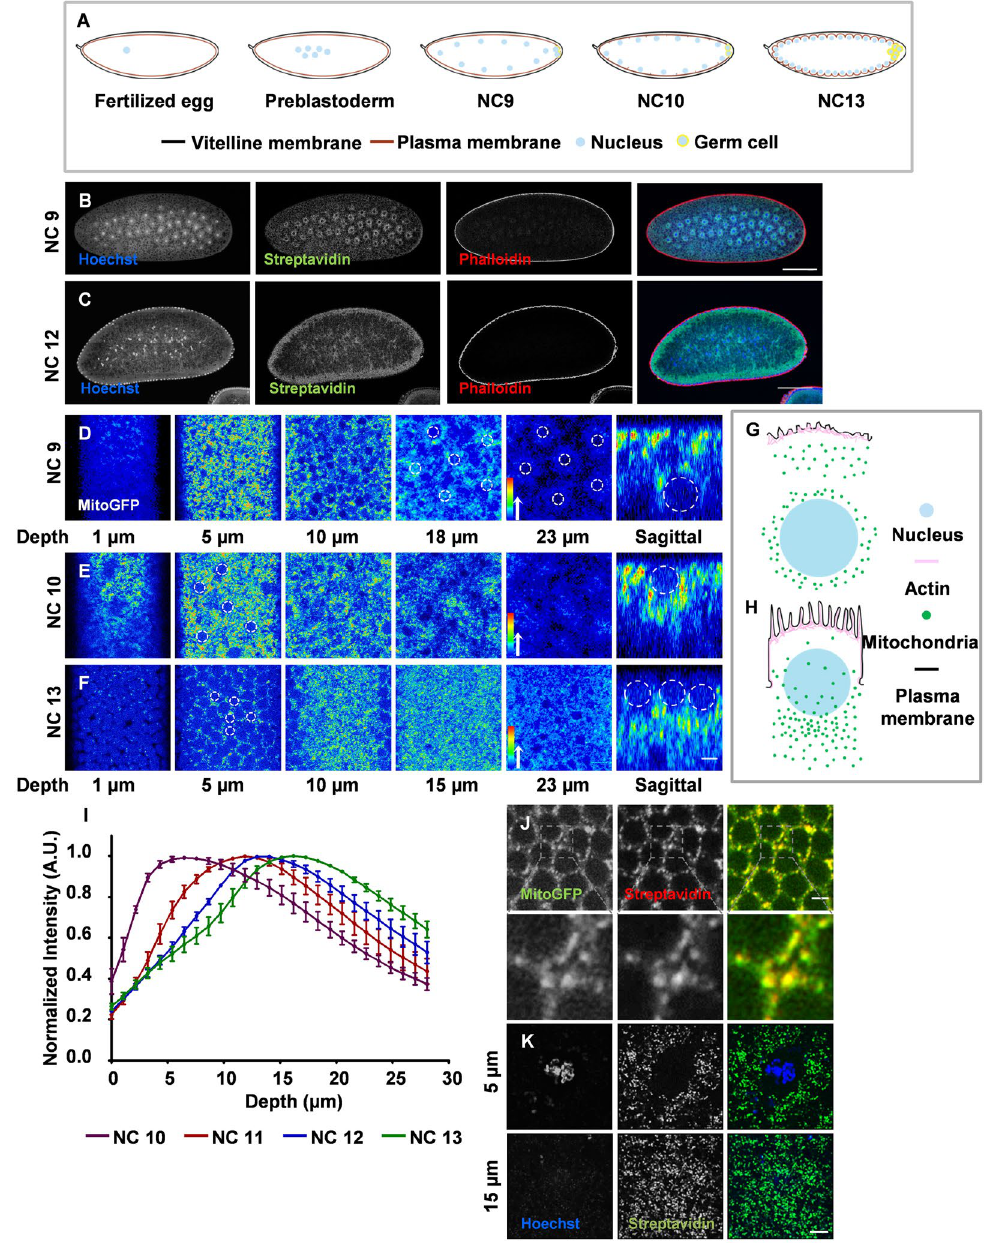
Figure 1. Mitochondrial distribution in syncytial Drosophila cycles. ( A ) Schematic showing nuclear cycles of Drosophila syncytial embryo. ( B , C ) Mitochondrial distribution in preblastoderm and blastoderm embryos. Mitochondria (Streptavidin; green) are seen around nuclei (Hoechst; blue) (Phalloidin; red) in the preblastoderm NC9 at approximately 23 µ m depth from the surface ( B ). Mitochondria are enriched around nuclei at the cortex in blastoderm NC12 ( C ). ( D – I ) Mitochondrial intensity increases with depth during syncytial cycles. Optical sections at depths shown were obtained from live imaging of embryos expressing Mito-GFP through the syncytial cycles. Mito-GFP is seen cortically and around nuclei (white dashed lines) at 23 µ m depth ( D ) and in sagittal section at NC9. Mitochondria distribute around nuclei as they arrive at 5 µ m in NC10 ( E ) and localize below the nuclei ( E , sagittal). Mitochondrial intensity is higher below the nuclei at 10–15 µ m depth in NC13 ( F ) and also seen in sagittal section ( F ). Schematic of mitochondrial distribution in sagittal view as seen in preblastoderm ( G ) and syncytial blastoderm embryos ( H ). Quantification of mean mitochondrial fluorescence intensity across depth from apical to basal region ( I ). n = 3 embryos/NC, 15, 30, 60 and 120 syncytial cells were quantified for NC10 (Purple), 11 (Red), 12 (Blue) and 13 (Green) respectively. Error bars show SEM. Rainbow scale represents pseudocolored intensities. ( J ) Streptavidin colocalizes with Mito-GFP. Mitochondria labelled with Mito-GFP (green) at NC13 are stained with fluorescent conjugated Streptavidin (red). ( K ) Mitochondria are small and dispersed in the syncytial embryo. High resolution imaging of dispersed mitochondria in NC11, Streptavidin (green); Nucleus (blue) at section through nucleus (5 µ m) and basal section (15 µ m). Scale bar B,C: 100 µ m, D-F: 10 µ m, J: 5 µ m, K: 2 µ